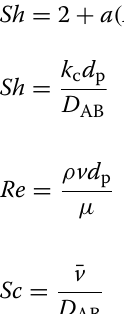
pH 6.56; Conductivity =